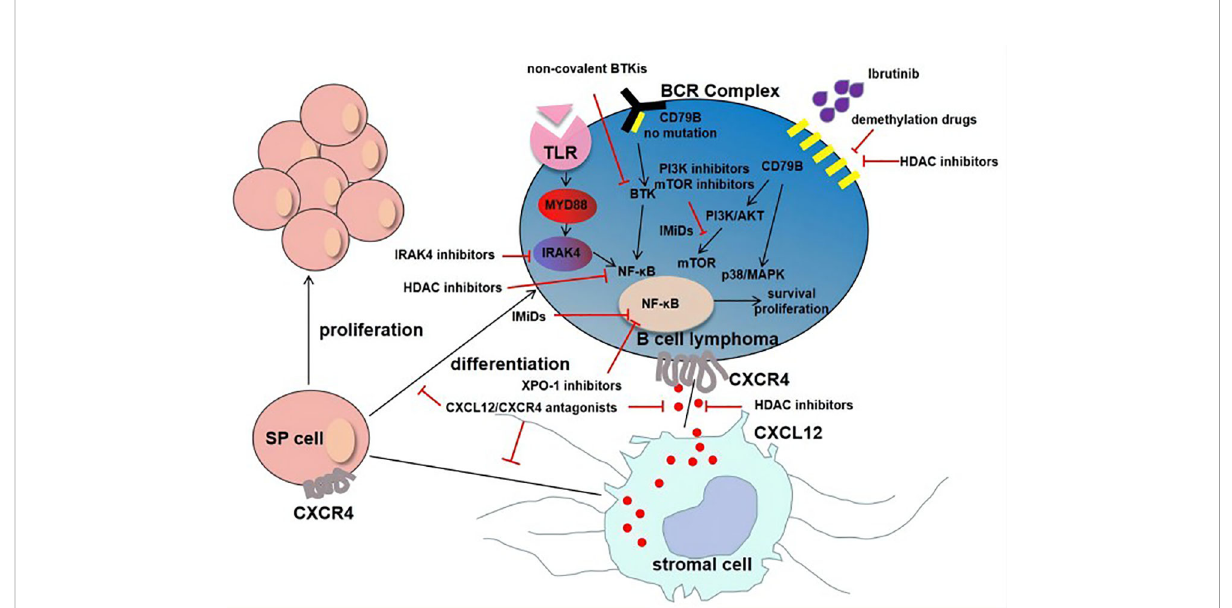
FIGURE 1 Mechanisms of ibrutinib resistance in PCNSL. For tumor cells without CD79B mutation, ibrutinib resistance was mainly due to MYD88- dependent survival signaling pathway (MYD88 ! IRAK4 ! NF- k B). Another important mechanism of resistance is adaptive activation of alternative signaling pathways involving CD79B overexpression and the activation of PI3K/Akt/mTOR pathway and p38/MAPK. The interaction of CXCL12 secreted by stromal cells and CXCR4 secreted by tumor cells promotes tumor growth and resistance. In addition, the existence of SP cells and extrinsic tumor microenvironment are also the mechanisms of drug